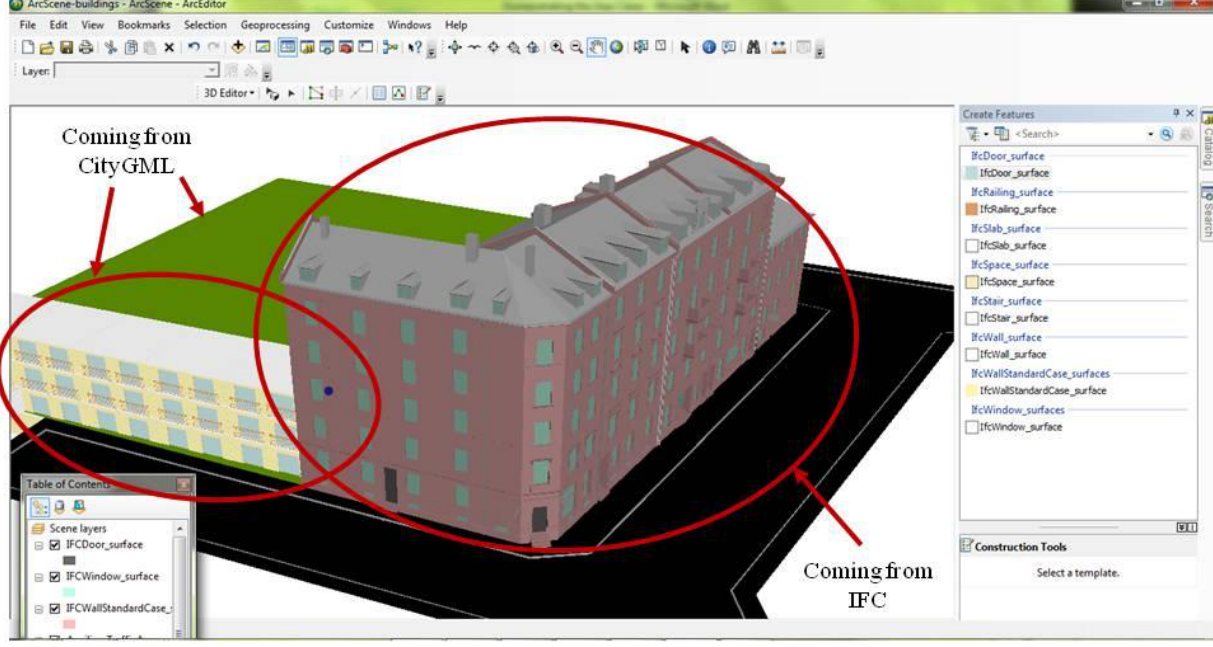
Figure 12. ( a ) A space to be tested versus the evacuation plan. ( b ) Connections from the space to all exits to be used for calculating distances and